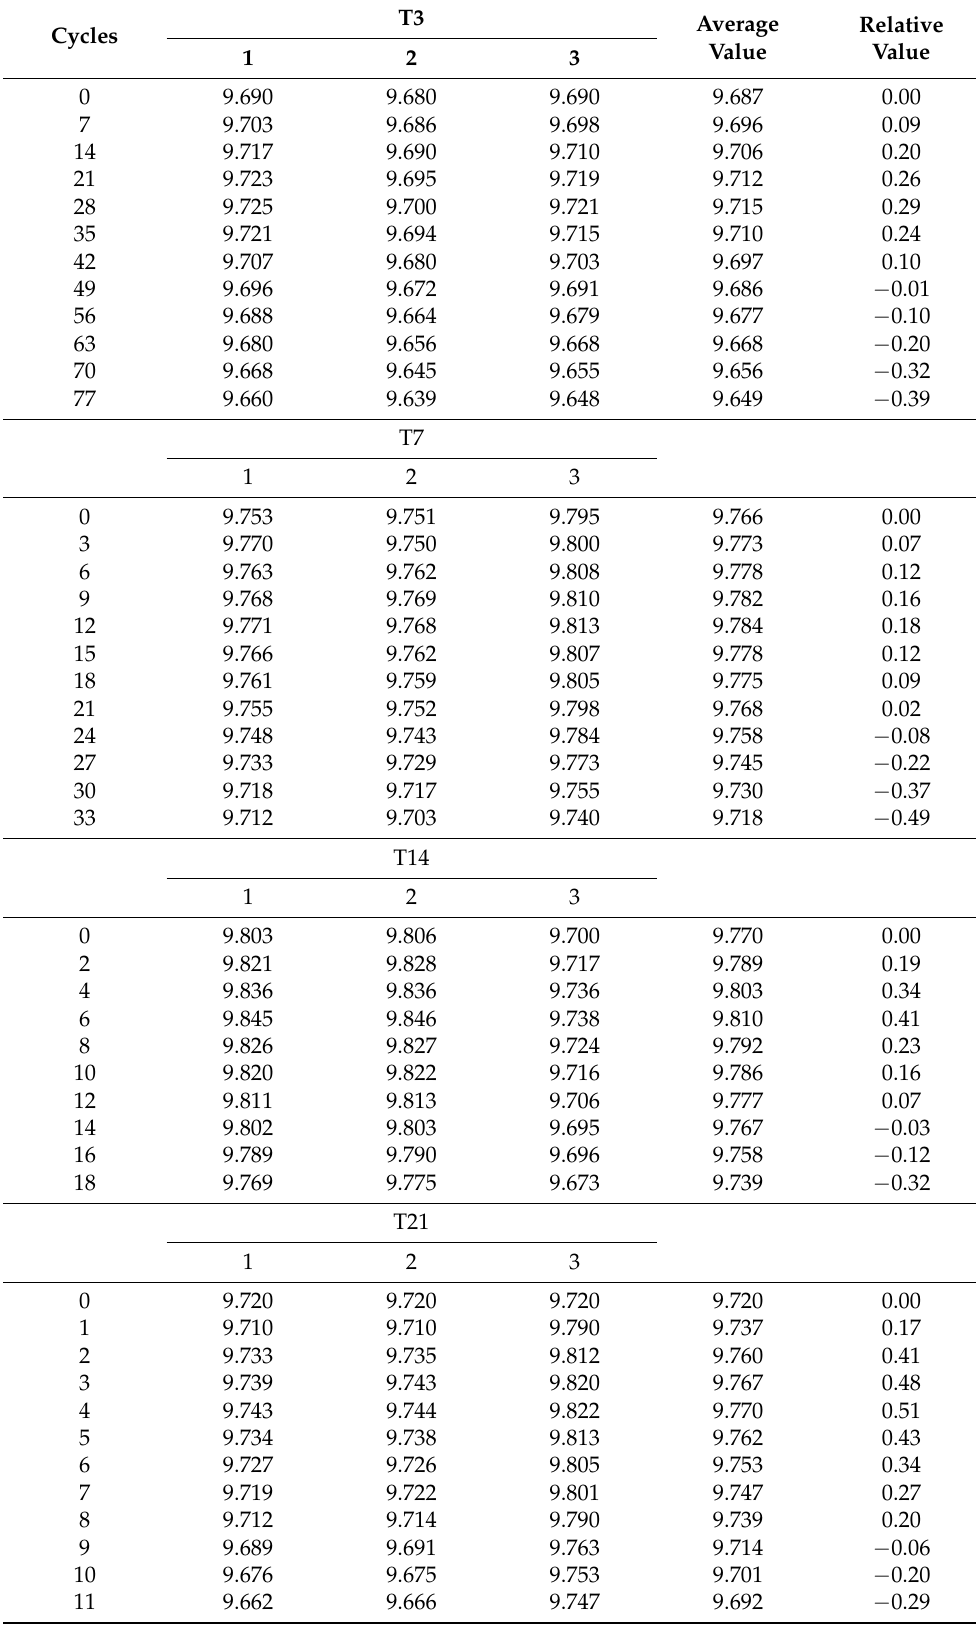
Table 6. The mass change in the experiment